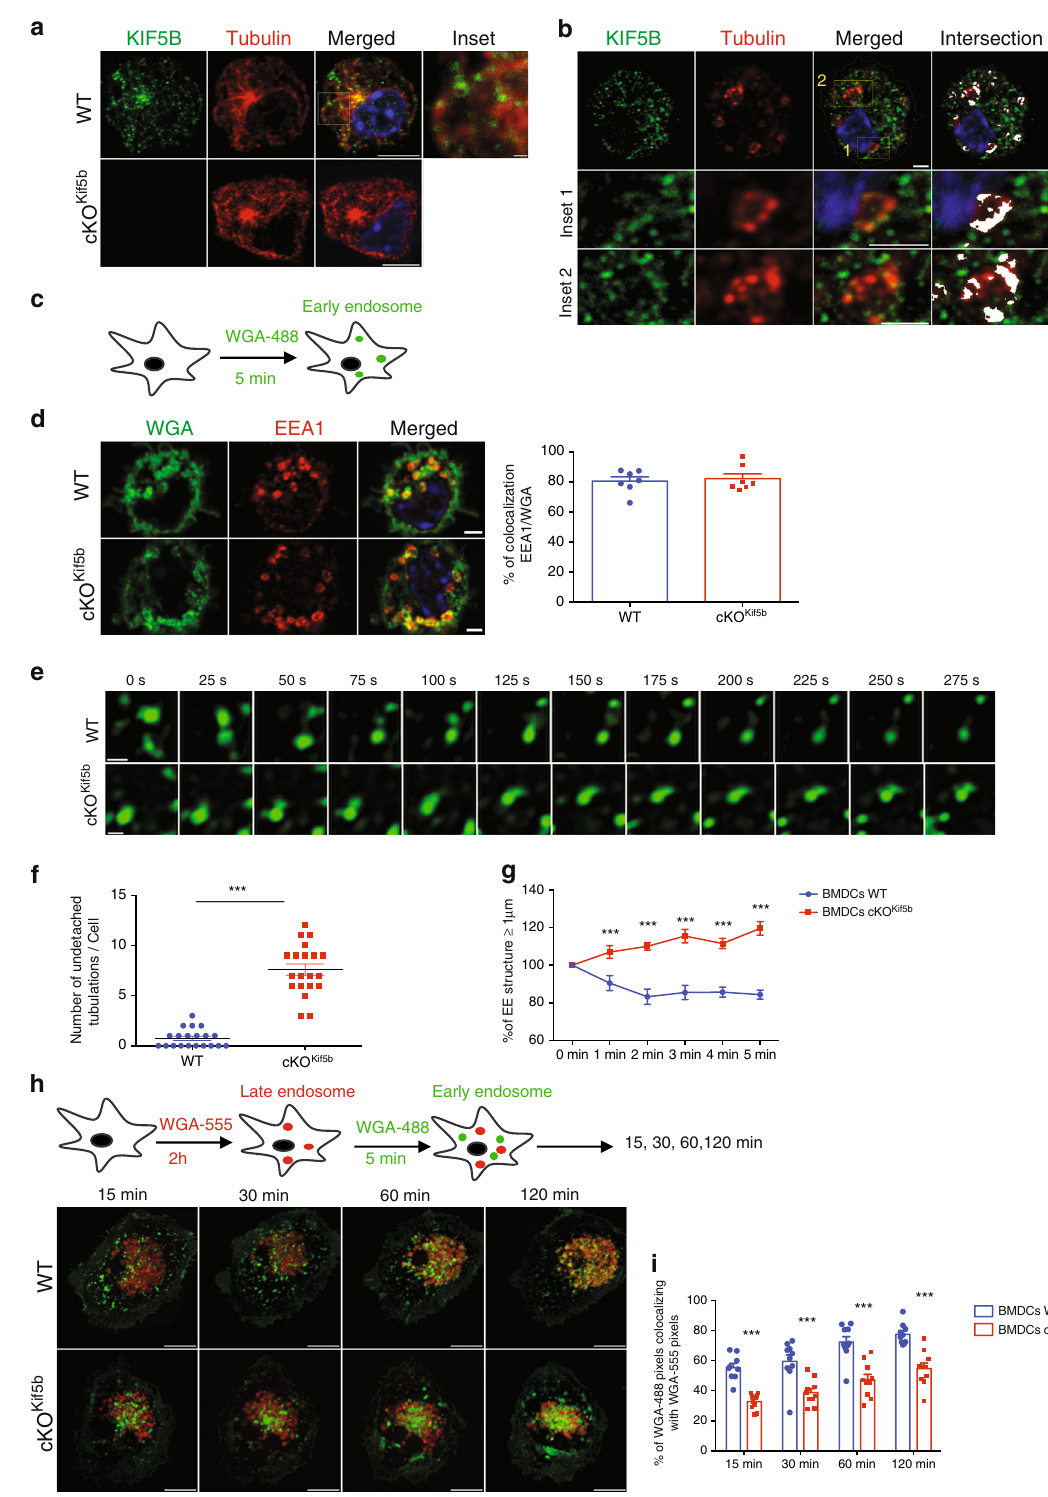
Methods Reagents and antibodies . Anti-CD11c (BV711 (BioLegend), APC (BD Bios- ciences) PB (Sony)), anti-IA/IE FITC (BD Biosciences), anti-CD8 α BV450 (Sony), anti-CD11b (PE (BD Biosciences), APC-CY7 (Sony)), anti-F4/80 PE/Cy7 (Sony), anti-GR1 APC (BD Biosciences), anti-CD19 (PerCP (BD Biosciences), PerCP/ Cy5.5 (Sony)), anti-B220 BV650 (BioLegend), anti-CD86 BV650 (Sony), anti- CD40 PE/Cy7 (Sony), mouse monoclonal Kif5b antibody (Biolegend), puri fi ed rabbit anti- α -tubulin (Rockland), goat anti-EEA1 antibody (Santa Cruz Bio- technology), rat anti-Lamp1 antibody (Invitrogen), H-2Kb PE antibody